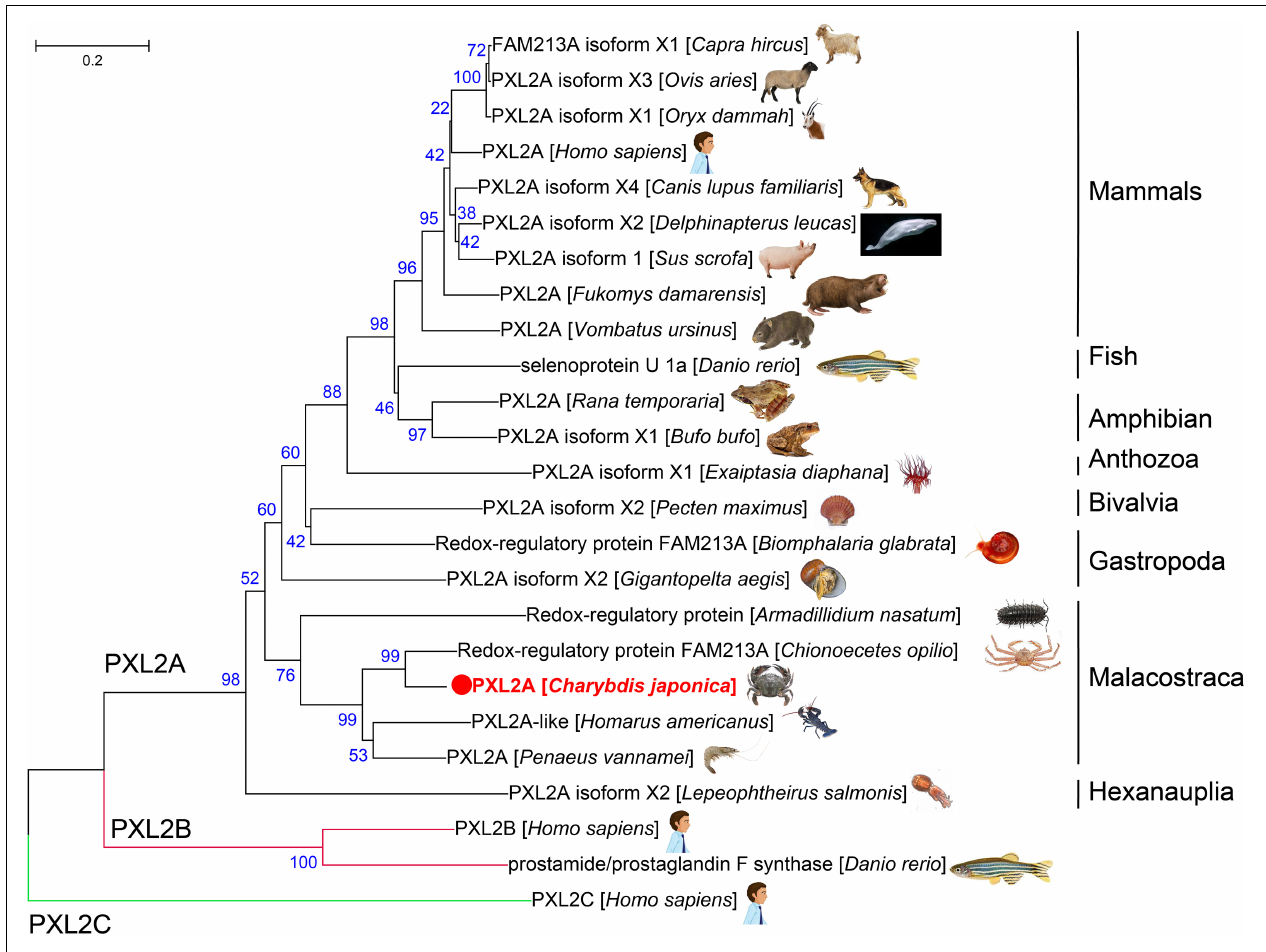
FIGURE 4 | Evolutionary relationships of PXL2A amino acid sequence of C. japonica and other